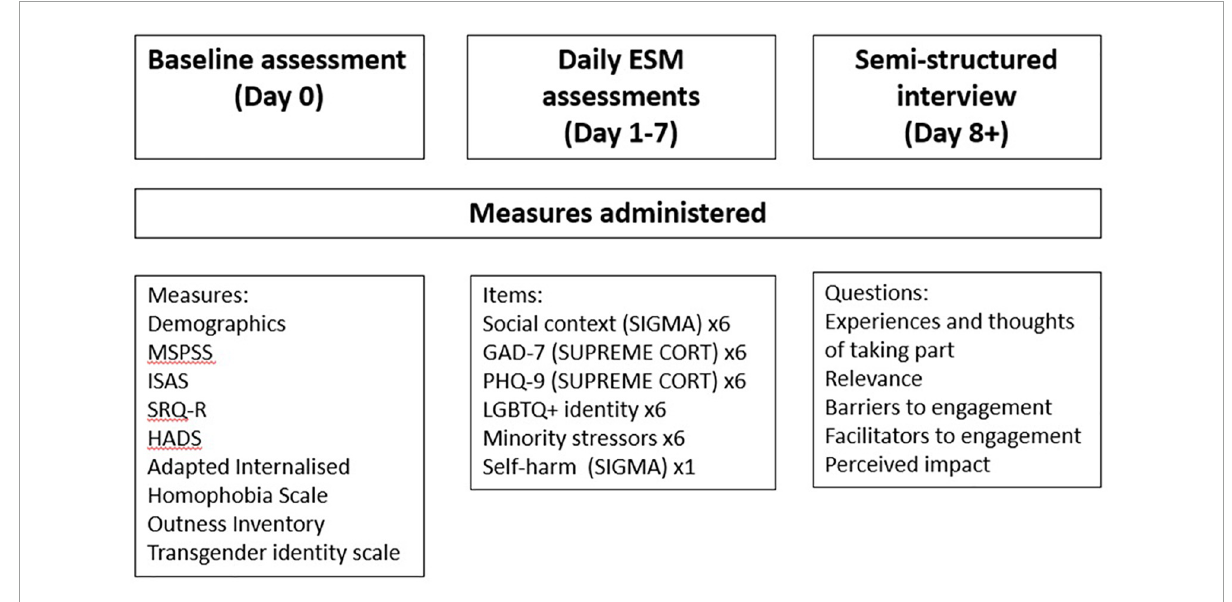
FIGURE1 Overview of data collection